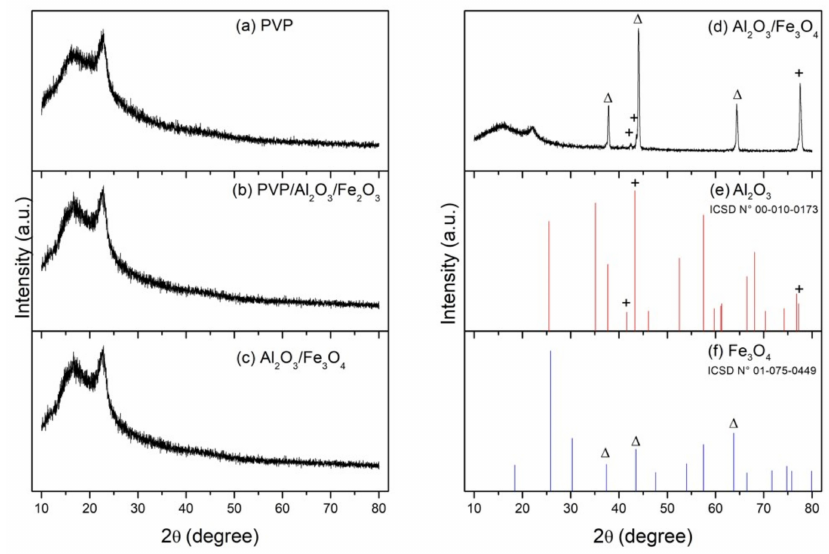
Figure 6. XRD patterns of ( a ) electrosprayed spherical PVP particles, ( b ) deposition of 50 cy- cles of Al 2 O 3 on spherical PVP particles with ALD (PVP/Al 2 O 3 ), ( c ) deposition of 500 cycles of Fe 2 O 3 on spherical PVP/Al 2 O 3 particles with ALD (PVP/Al 2 O 3 /Fe 2 O 3 ), ( d ) thermal reduction of PVP/Al 2 O 3 /Fe 2 O 3 particles to obtain hollow Fe 3 O 4 nanospheres (+) and traces of Al 2 O 3 ( ∆ ), ( e ) diffraction peaks of standard card ICSD no. 01-010-0173 and ( f ) diffraction peaks of standard card ICSD no.